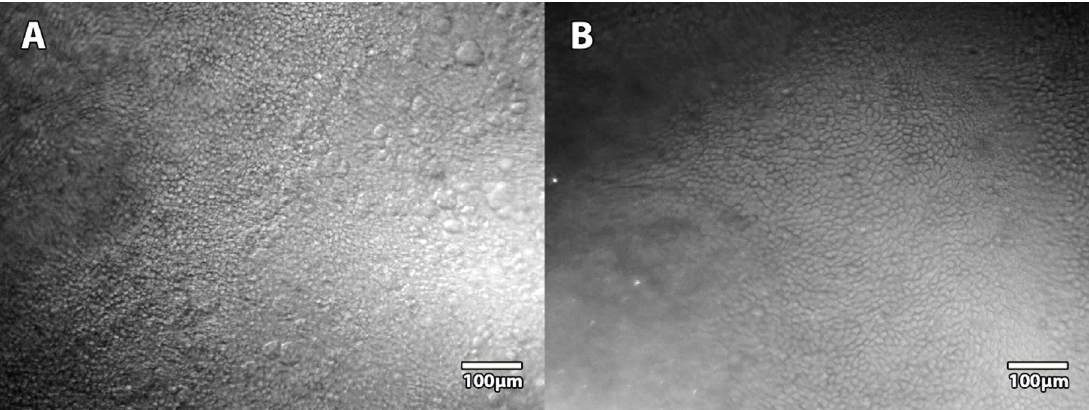
Figure 6. Specular microscopy images of the epithelium of corneas stored in the active storage machine. Thanks to the precision of the Z axis of the microscope stage and the variation of angulation of the LED source, we were able to record epithelium images at different depths: superficial layers ( A ) and more basal layers ( B ).